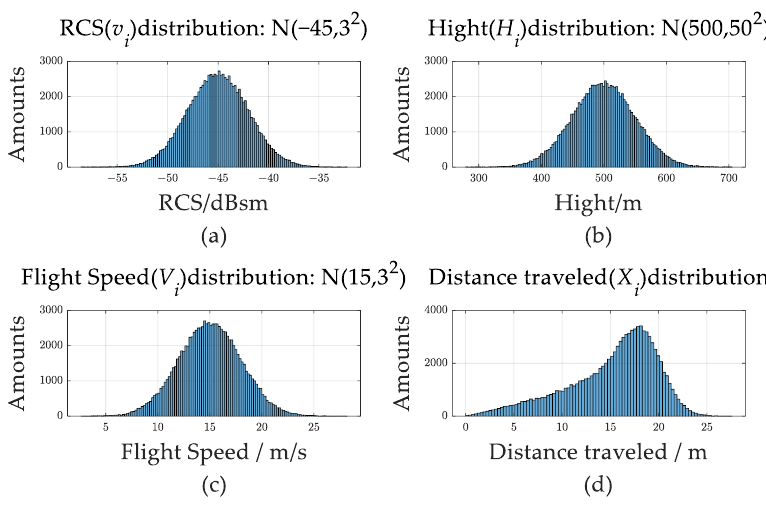
Figure 7. Simulation input conditions. ( a ) RCS v i distribution. ( b ) Height H i distribution. ( c ) Speed V i distribution. ( d ) Real crossing distance X i distribution.